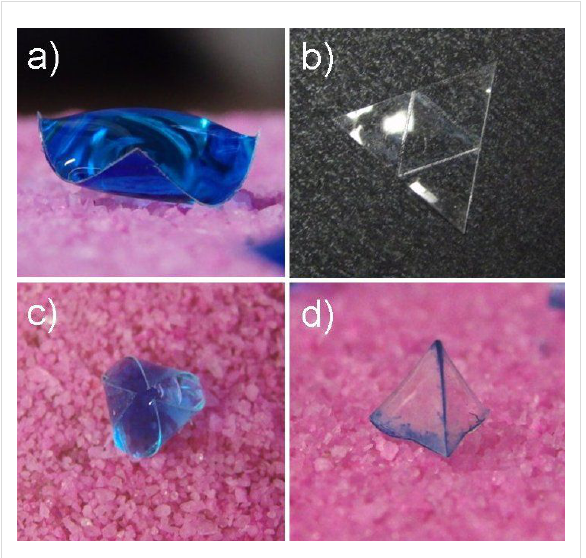
Figure 1: Effect of droplets of blue-dyed water on a thin polydimethyl- siloxane (PDMS) membrane: a) droplet causing bending of the substrate, b) initial shaped substrate with the three score lines for folding, c) droplet induced folding, and d) three-dimensional shape left after completion of